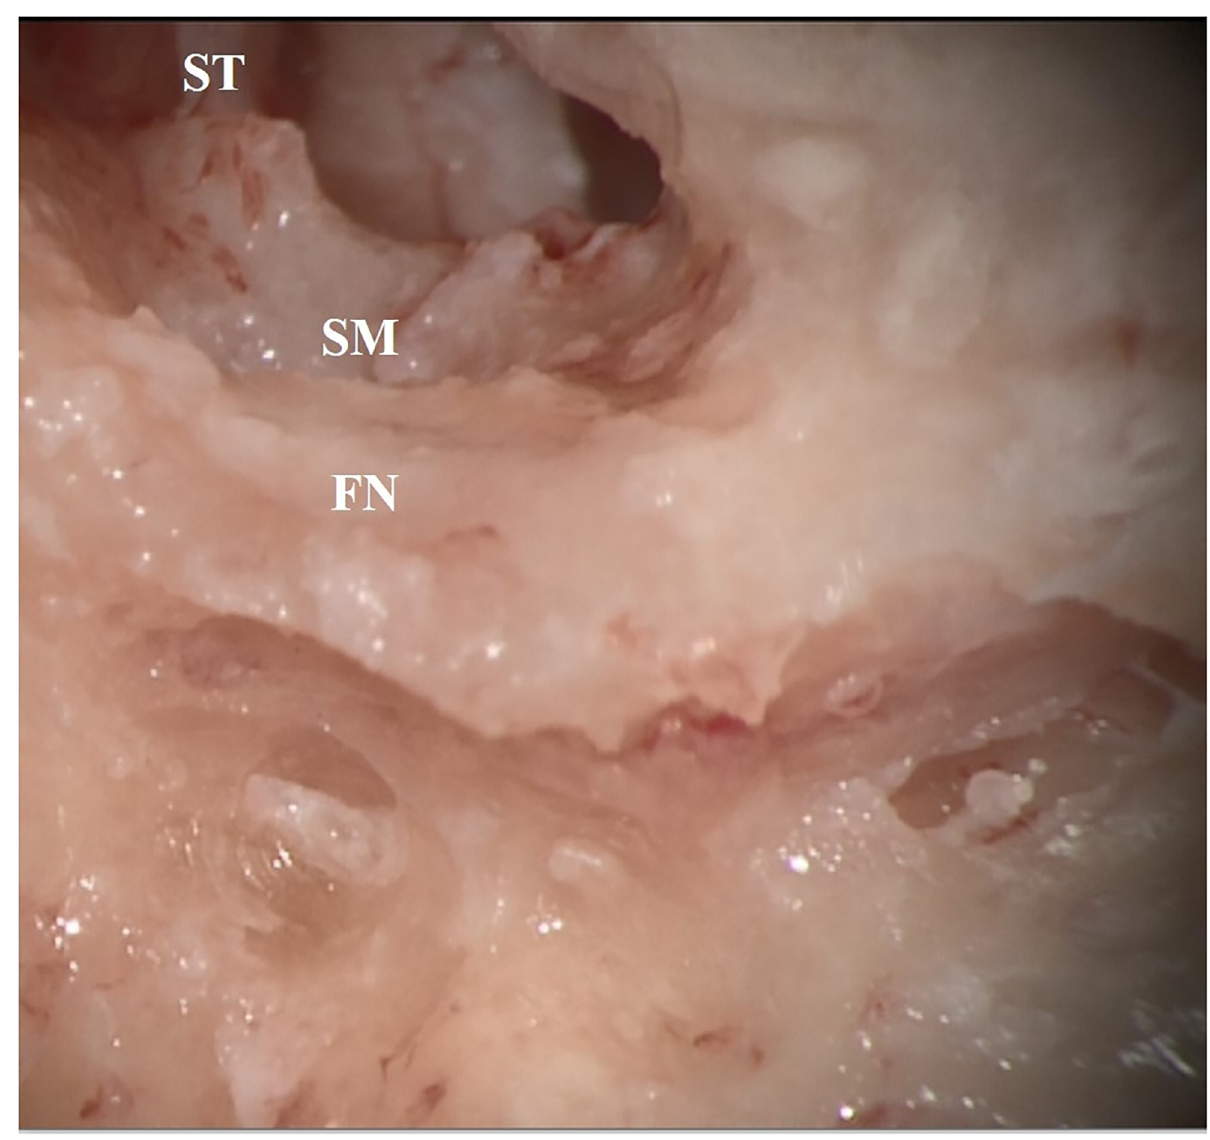
Fig 4. Higher magnification of the upper case of Fig 3, right ear. Surgical view form the microscope preceding the decision of the surgeon of switching from the retrofacial approach to the anterior approach with drilling of the pyramidal eminence (PE) to access the SM. After clear and deep exposition of the FN course, the SM appeared out of reach through the retrofacial approach. Therefore, the surgical approach was changed towards an anterior approach. Screenshot taken from intraoperative microscope recordings. FN: facial nerve, SM: stapedius muscle, ST: stapedius tendon.